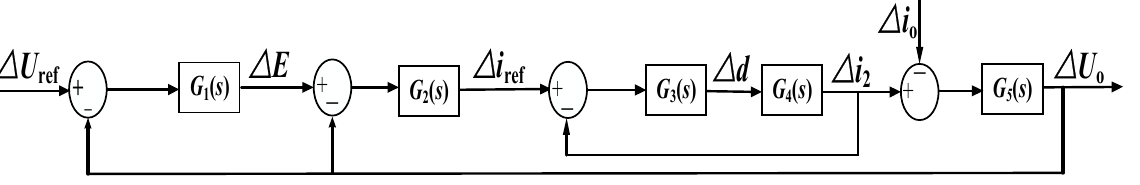
Figure 6. Small signal model of DAB DC converter.